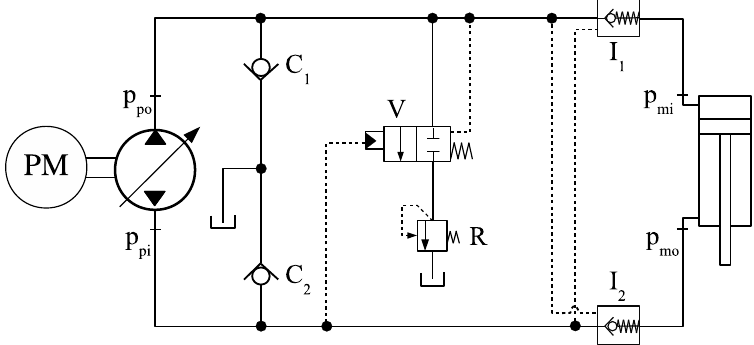
Figure 20. Status of the directional valves V 1 and V 2 for different circuit pressures.